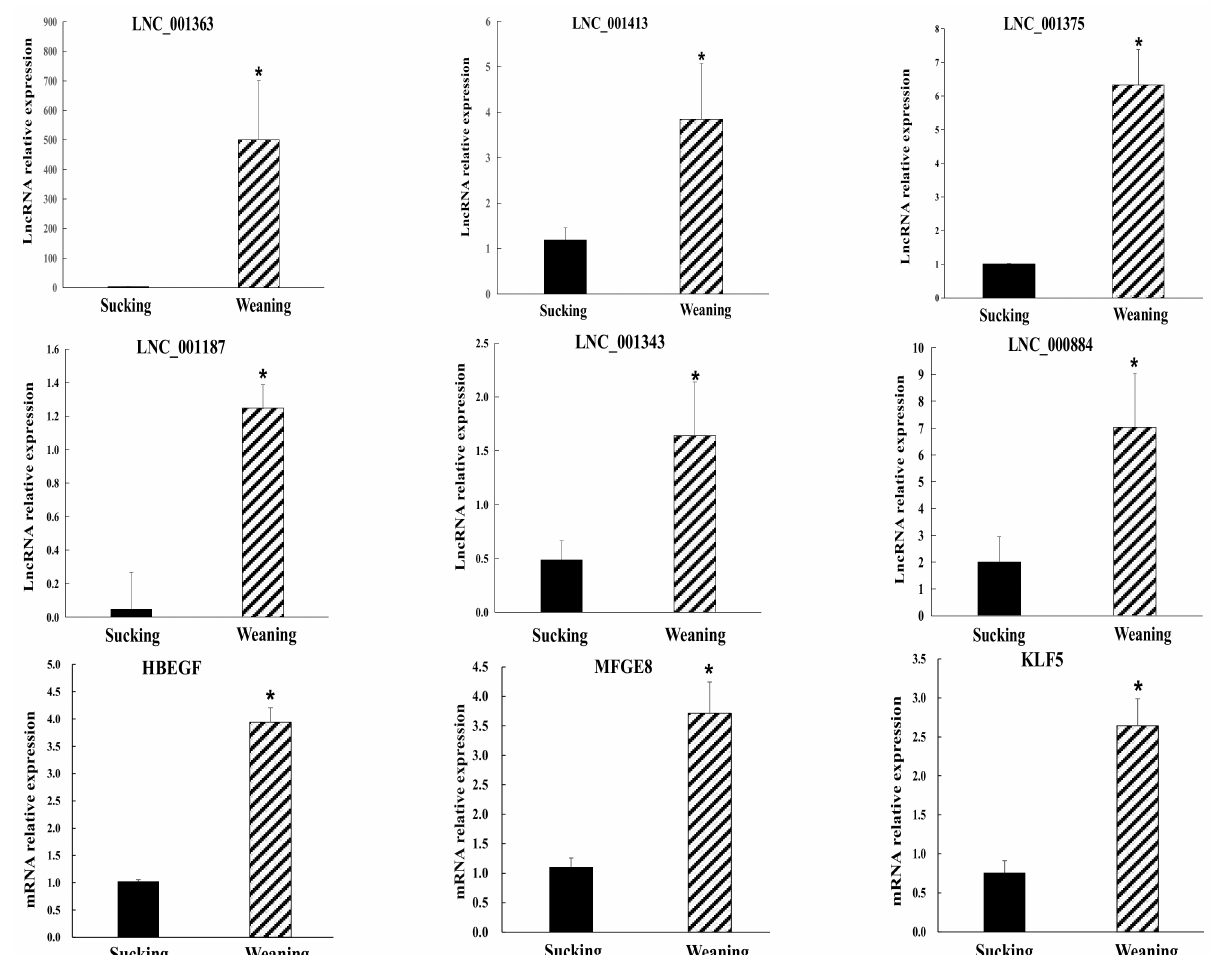
Figure 5. Validation of RNA-seq results by RT-PCR analysis. Relative transcript expression levels were normalized against 18S rRNA using the 2 − ∆∆ Ct method; data are shown as means ± SEM. * p <